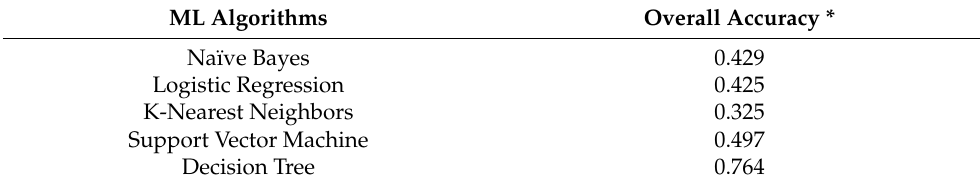
Table 1. Screening modeling phase algorithms overall